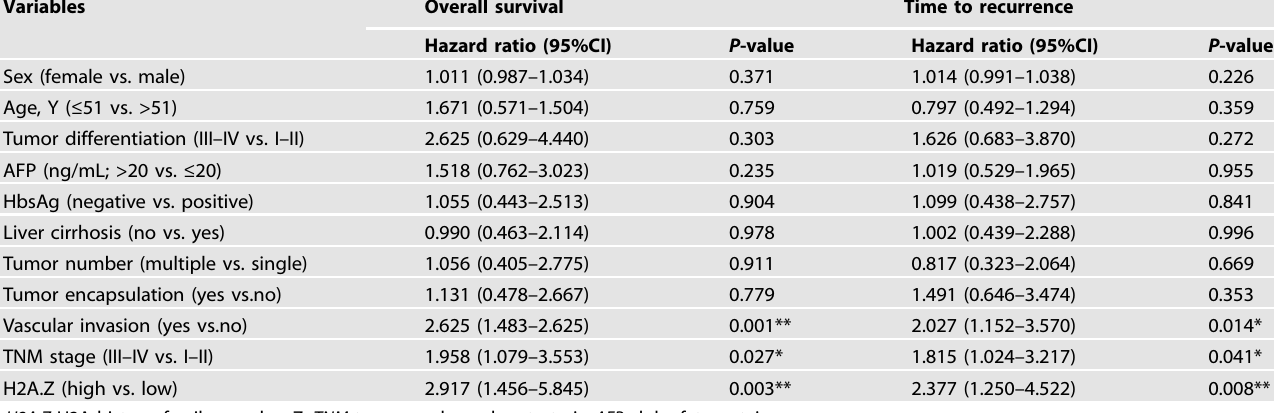
Table 1. Cox regression analyses of factors associated with OS and TTR of HCC patients ( n = 96).